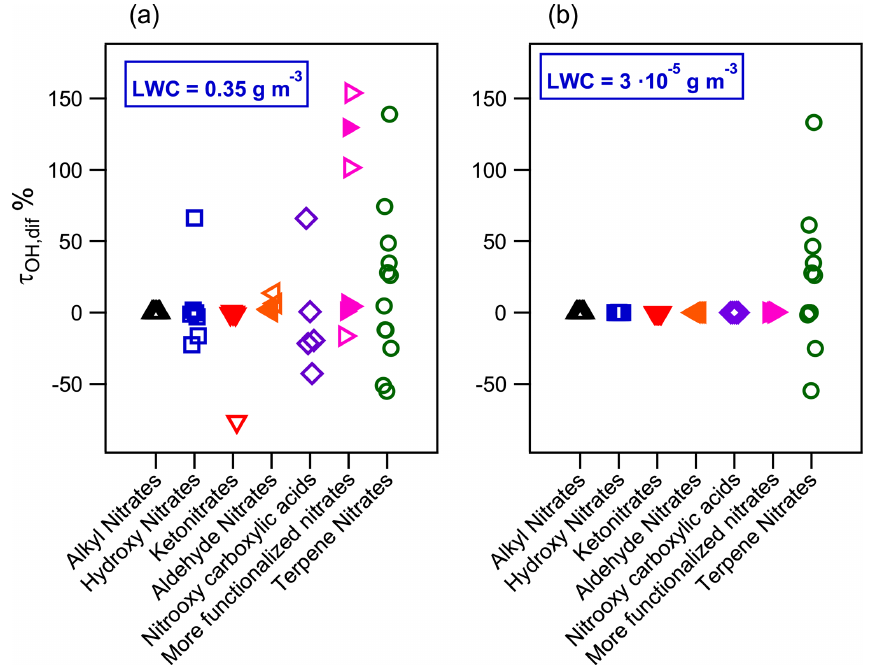
(cid:113) Figure 9. Relative difference of OH-oxidation lifetimes between an air parcel with and without liquid water at (a) LWC = 0.35gm − 3 and (b) LWC = 3 × 10 − 5 gm − 3 for atmospherically relevant organic nitrates. Filled markers represent organic nitrates derived from isoprene. pound using Eq.